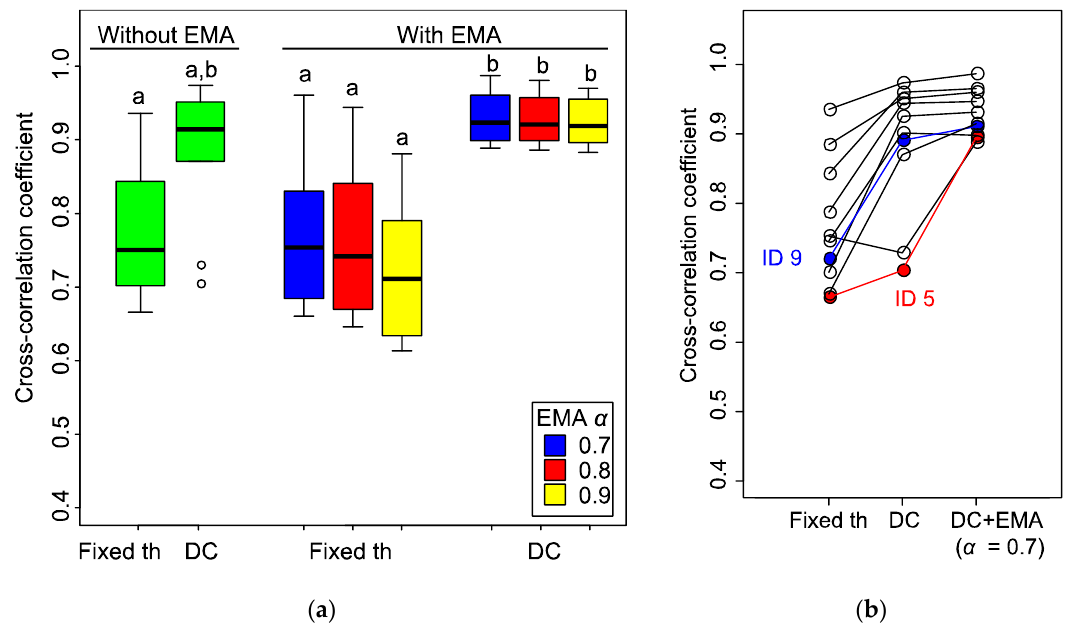
are shown. Note that th in the fixed threshold is an absolute voltage, whereas th in D-counter is a